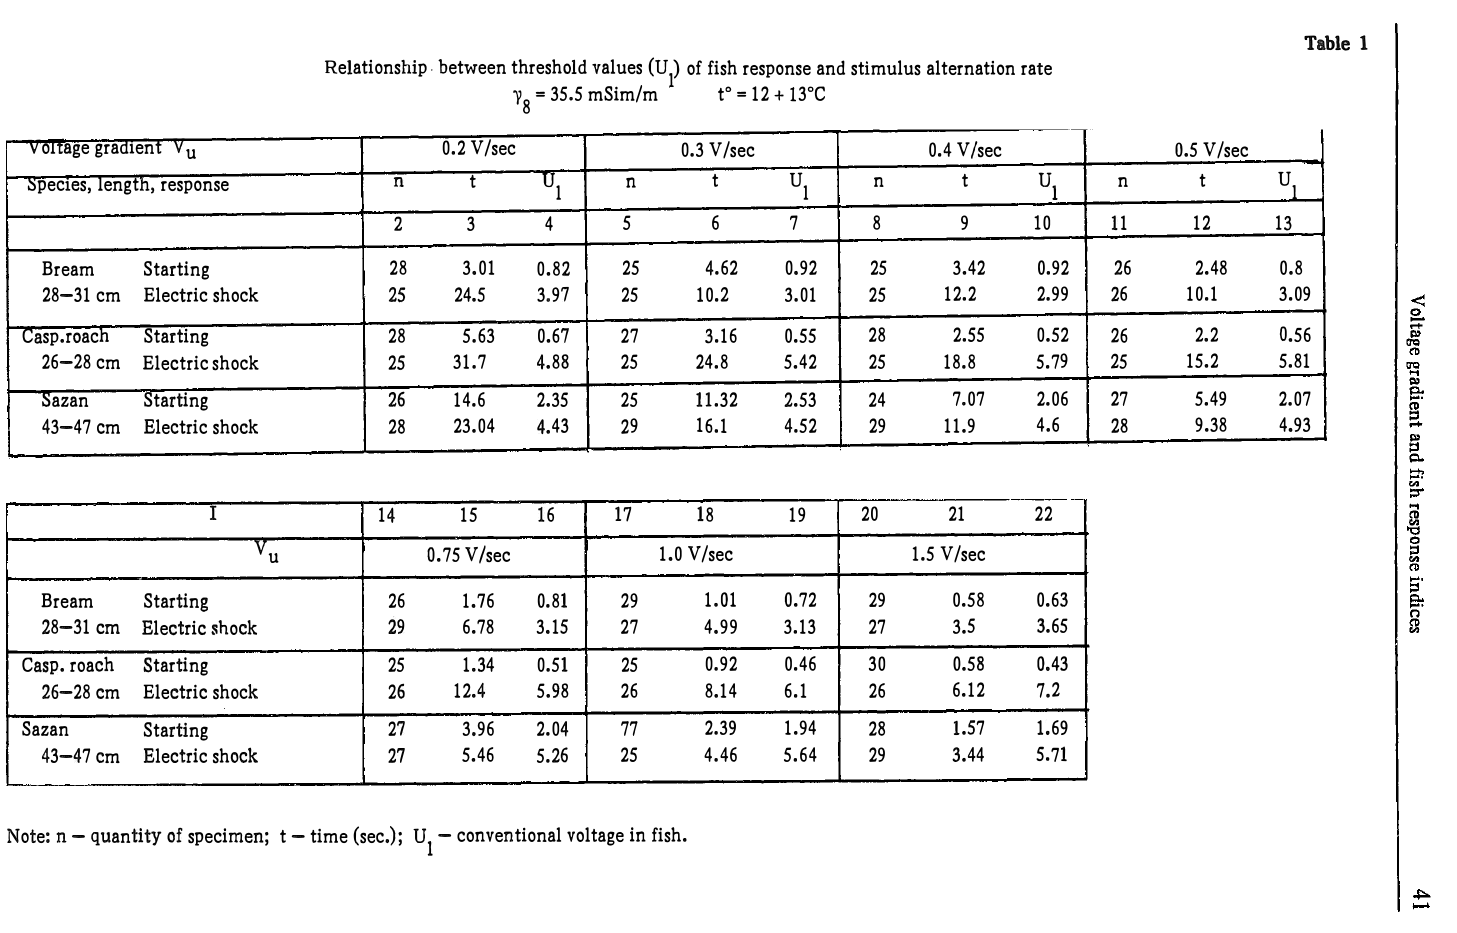
Relationship. between threshold values (U 1) of fish response and stimulus alternation